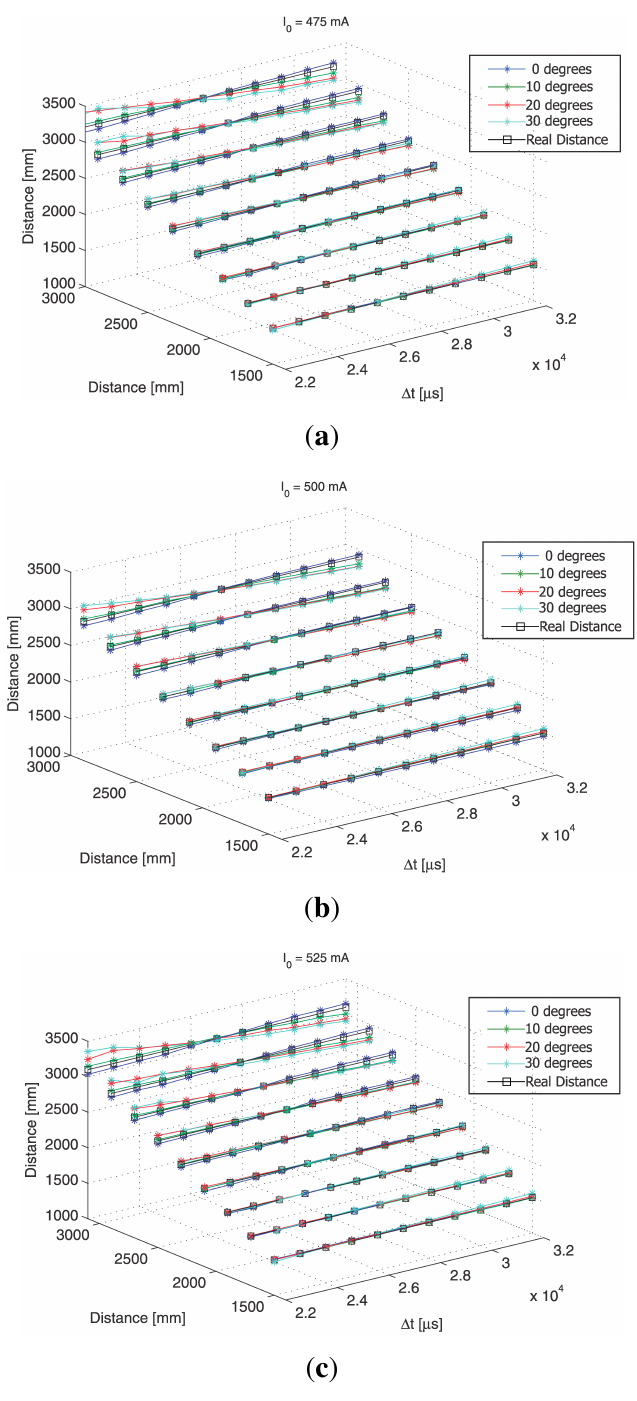
Figure 11. Results of distance estimation process as a function of (cid:52) t for all IRED orientation angles